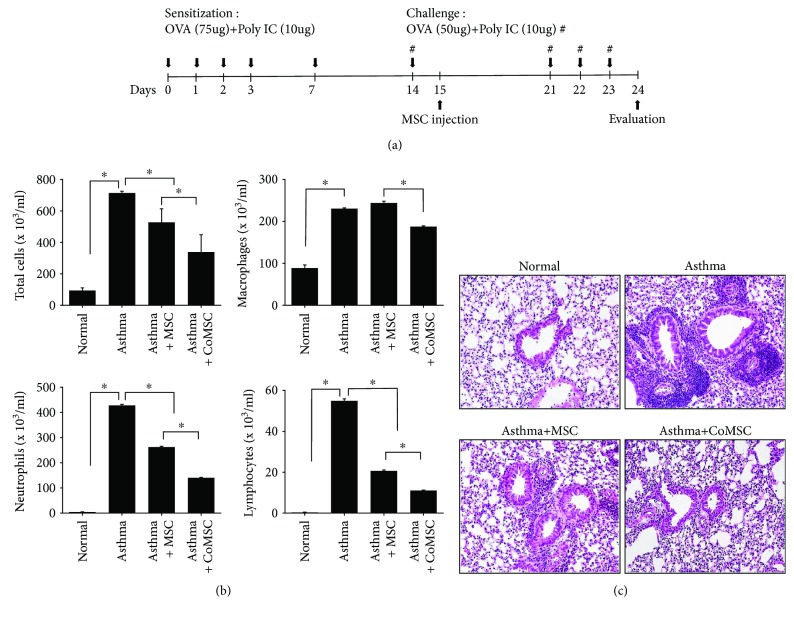
Administration of cobalt chloride- (CoCl2-) treated hUCB-MSCs inhibited airway inflammation in a mouse model of asthma. (a) Schematic of the experimental studies. (b) BALF cell differentials in naïve hUCB-MSCs, CoCl2-treated hUCB-MSCs, and PBS-treated asthma mouse models. (c) Representative photomicrographs stained with hematoxylin and eosin depicting histologic inflammation on day 24 for asthma models are depicted for each experimental condition. ∗
p < 0.05. MSC: naïve hUCB-MSCs; CoMSC: CoCl2-pretreated hUCB-MSCs.